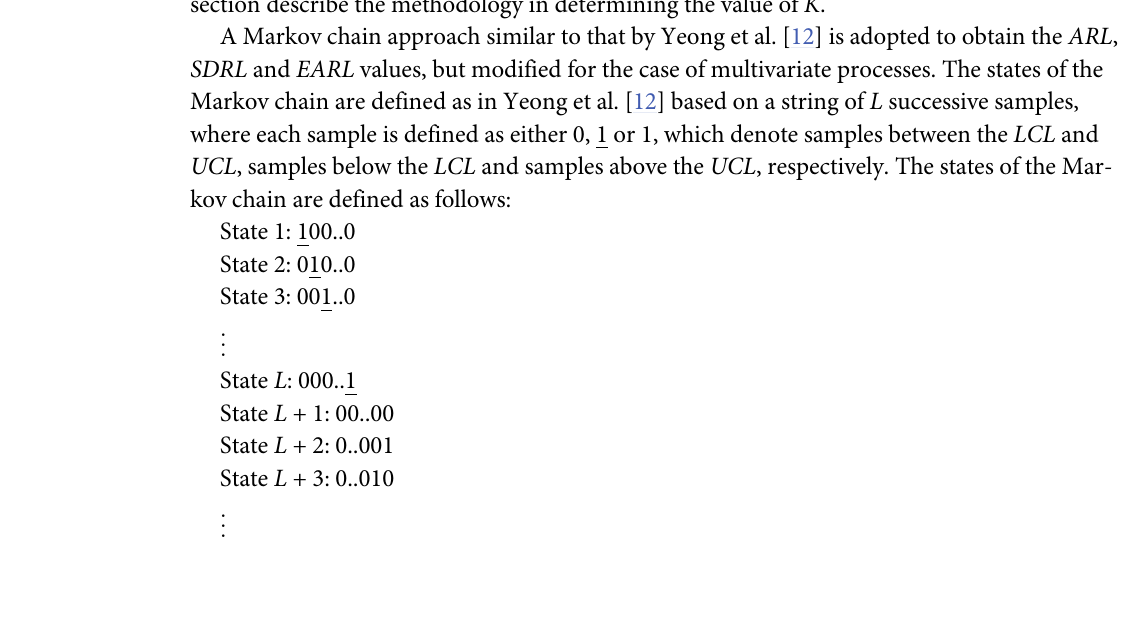
where m ð ^ g 2 Þ and s ð ^ g 2 Þ are the in-control mean and standard deviation of ^ g 2 which is 0 0 obtained from Eqs (7) and (8), respectively, by evaluating the first and second moments of F ’ by letting g 2 ¼ g 2 , with γ being the in-control value of γ , while K is the control limit coefficient 0 0 that controls the width of the region between LCL and UCL . The last two paragraphs of this section describe the methodology in determining the value of K .